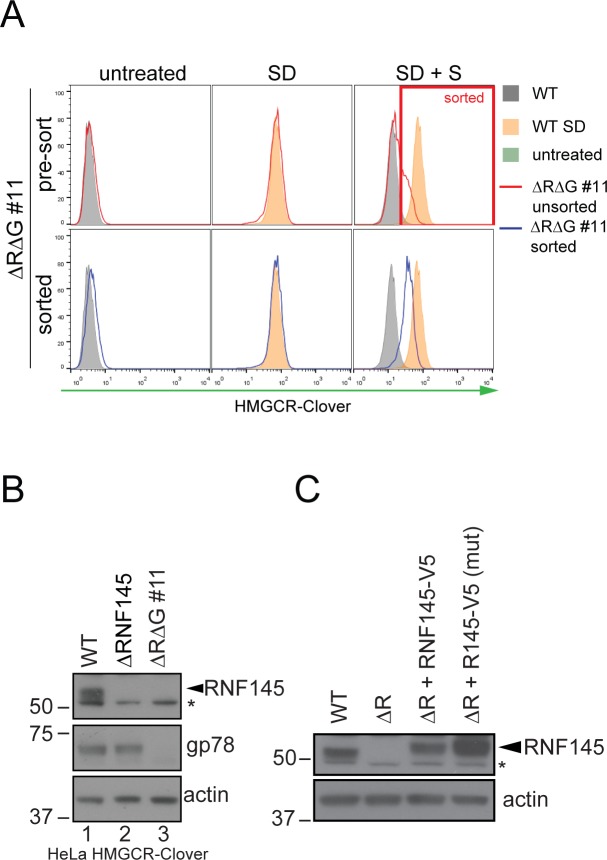
Establishment of RNF145/gp78 knockout HeLa HMCR-Clover and RNF145 complementation cell lines.(A) HeLa HMGCR-Clover cells were transfected with RNF145 sgRNA#8 and gp78 sgRNA#4 (ΔRΔG #11, for sgRNAs used see Supplementary file 4 and 5) and knockout pools were enriched with puromycin. Eight days post transfection, cells were sterol-depleted (SD) overnight ± sterols (S, 2 hr). HMGCR-Cloverhigh cells were enriched by FACS (indicated). (B) RNF145 and gp78 levels in WT versus ∆RNF145 (clone #5) and RNF145/gp78-depleted (∆R∆G #11) HeLa HMGCR-Clover cells. (C) Stable genetic complementation of ΔRNF145 HeLa cells (ΔR, clone #4) by transduction with constructs encoding either RNF145-V5 (ΔR + RNF145-V5) or RNF145(C552A, H554A)-V5 (ΔR + RNF145-V5 (mut)). RNF145 variants were detected using an RNF145-specific antibody. Non-specific bands are indicated (*).